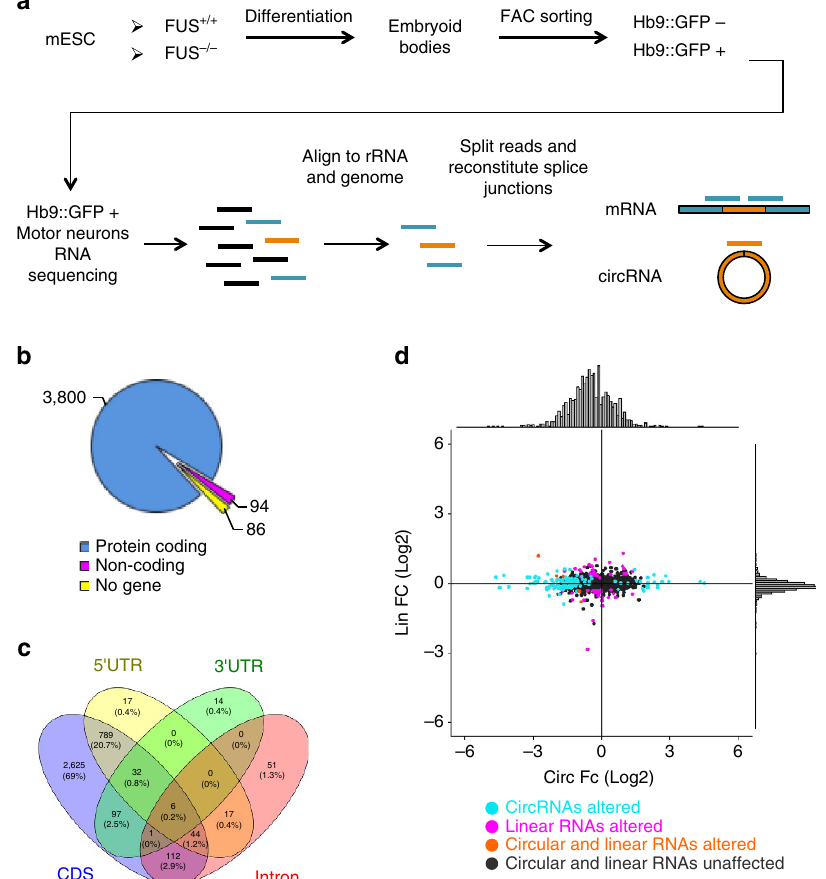
Figure 1 | mESC in vitro differentiation to spinal motor neurons and RNA-seq analysis. ( a ) Schematic overview of the murine motor neuron differentiation protocol and of the RNA-seq analysis. The procedures are reported in Supplementary Fig. 1a and in Methods section. ( b ) Pie chart showing the number of circRNAs hosted by protein-coding, non-coding genes and intergenic regions (No gene). ( c ) Venn diagram showing circRNA localization within the body of protein-coding genes. Numbers refer to circRNA species for each category. ( d ) Scatter plot showing the correlation of log2 fold change of circRNAs ( x axis) and their cognate linear RNAs ( y axis) in FUS (cid:2) / (cid:2) conditions. The distributions of the fold change values are shown above and aside the scatter plot. Turquoise dots indicate when only circRNA species are altered in FUS (cid:2) / (cid:2) ; magenta dots indicate when only linear RNAs are deregulated; circRNA and linear counterparts either deregulated or unaffected are indicated by orange and black dots, respectively.